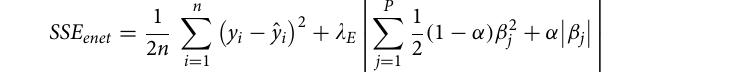
Elastic net regression. Elastic net is a form of regularised regression that incorporates a mixture of the lasso (L1) and ridge (L2) penalties and can be described as;